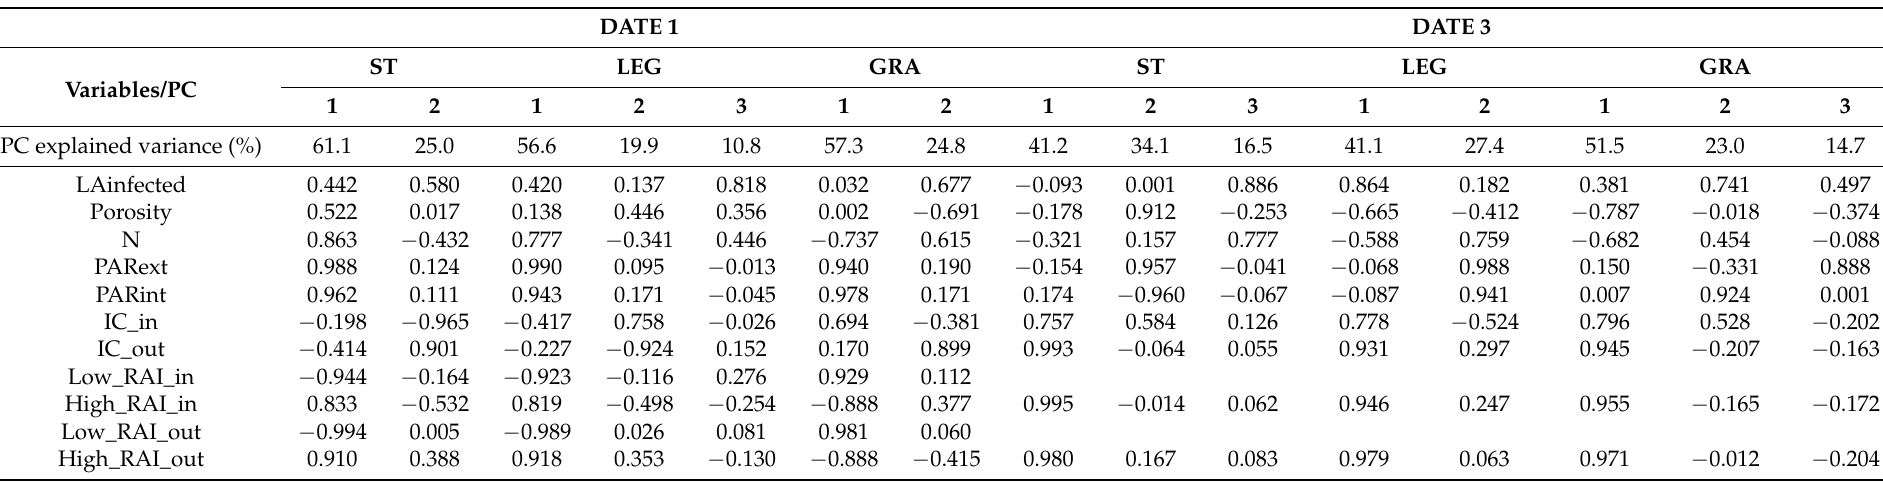
Table A5. Correlations between the principal components and the original variables in the multifactor analysis, showing significant differences among soil management treatment during dates 1 and 3 of grapevine and powdery mildew